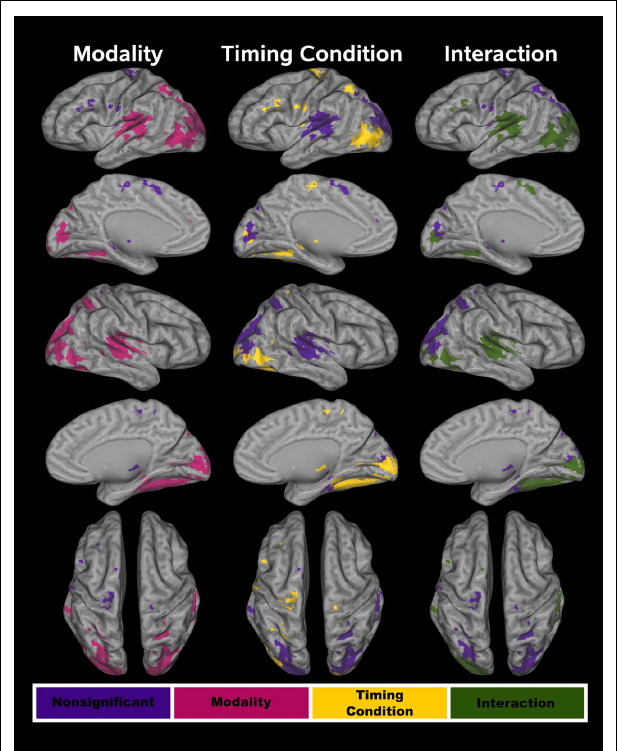
FIGURE 3 | Cortical functional ROI (fROI). Twenty-one cortical fROI were identified by conjoining activation maps from the voxel-wise analyses.Tests of modality, timing condition, and the interaction were conducted on these fROI.The fROI are color coded according to whether activation was affected by each of these factors. In all three columns, purple denotes no effect of a particular factor on activation. For the test of modality (left column), red designates a significant difference between the A–A andV–V conditions. For the test of timing condition (middle column), yellow signifies a significant difference between the unimodal and the crossmodal conditions. In the right column, green signifies a significant CI modality × timing condition interaction.